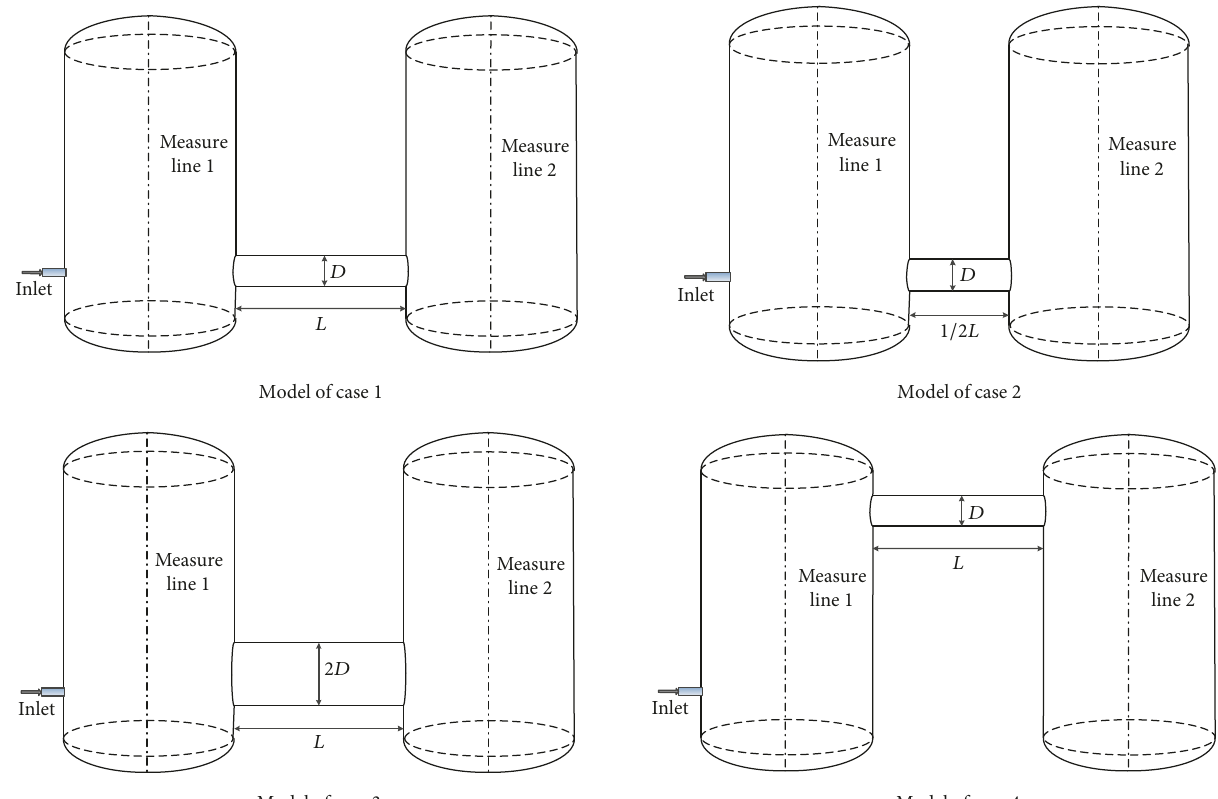
Figure 4: Geometric model of two